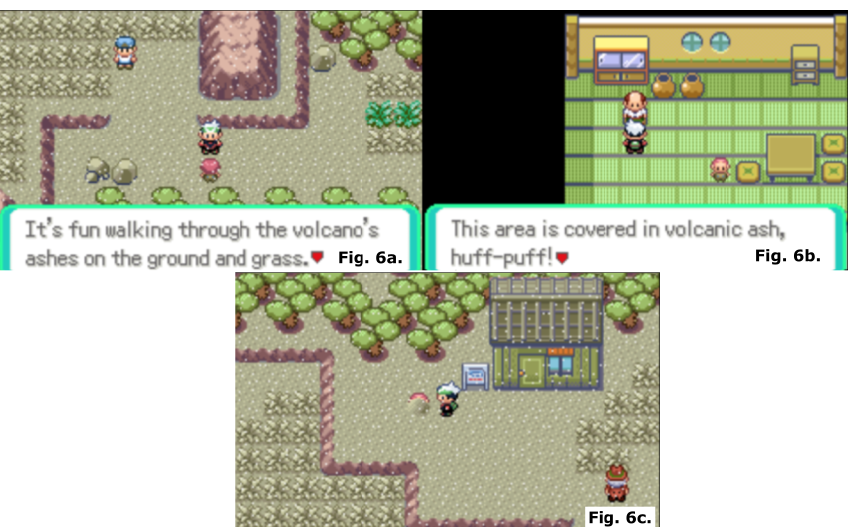
Figure 6. The effects of volcanic ash from the volcano Mt. Chimney on local residents in Pokémon Emerald © The Pokémon Com- pany